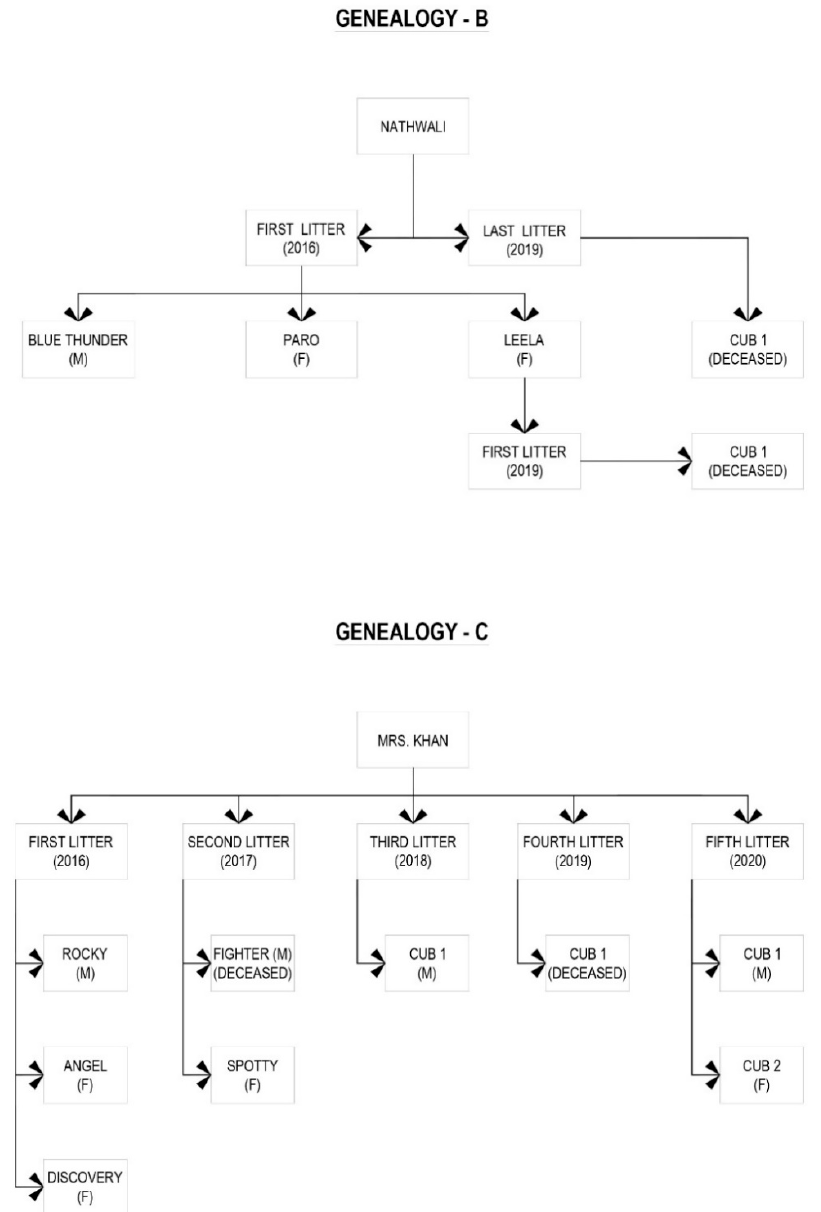
Figure 3. Genealogy of the three, dominant female leopards (( A )—Arti, ( B )—Nathwali, ( C )—Mrs Khan) of Jhalana Forest Reserve. Data correct for June 2020.